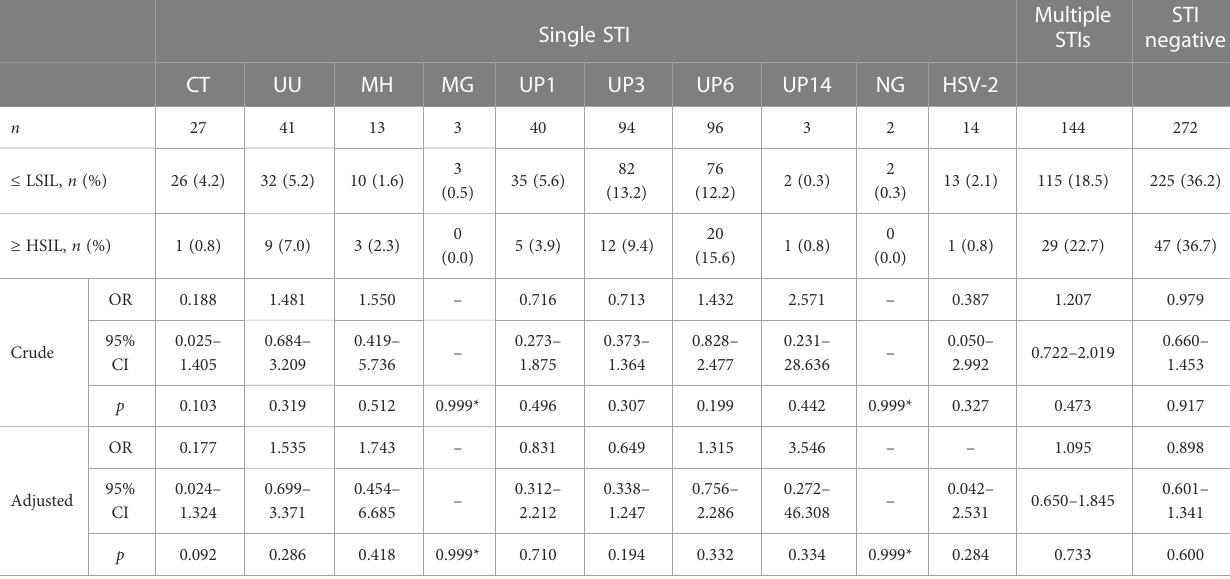
TABLE 6 Infection rates of STIs in groups with different cervical biopsy results.